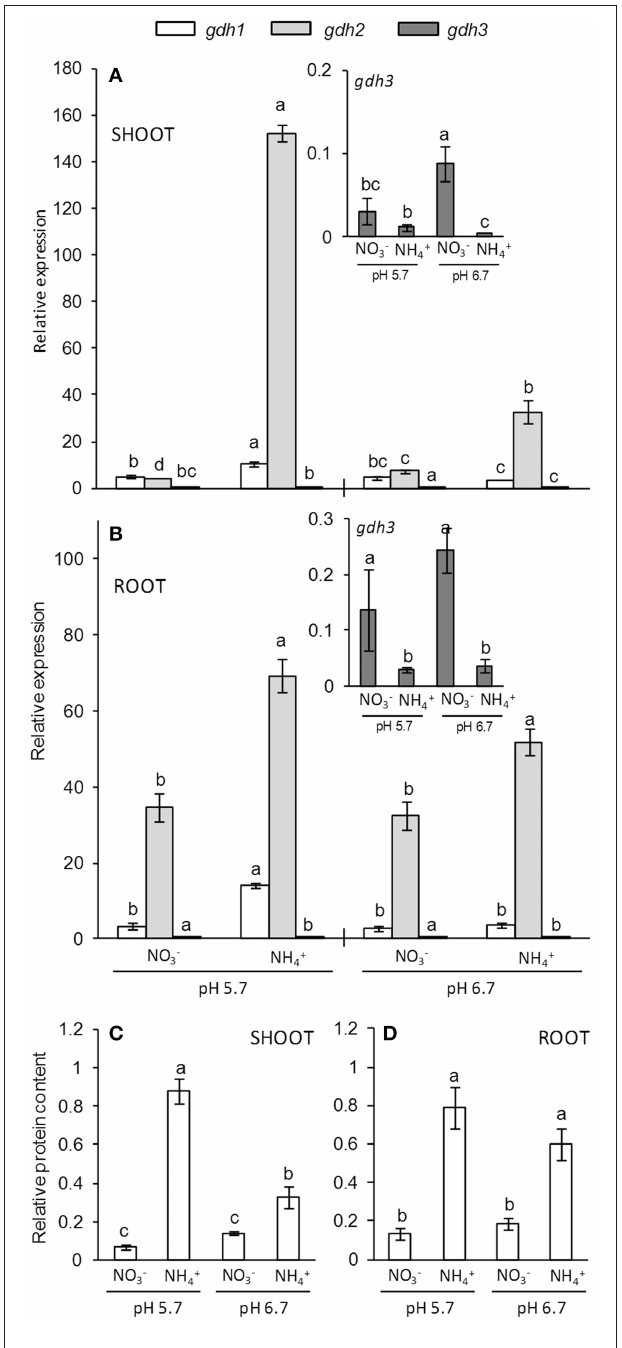
FIGURE 5 | GDH genes expression (A,B) and protein content (C,D) of shoots (A,C) and roots (B,D) of plants grown under 10mM N concentration at pH 5.7 or 6.7 and NO − 3 or NH + 4 as N source. The insets show the details for gdh3 expression. Letters represent significant differences between treatments analyzed by Duncan’s test ( p < 0.05 ). Columns represent mean ± se ( n = 3 ). Each sample is a pool of three plants.